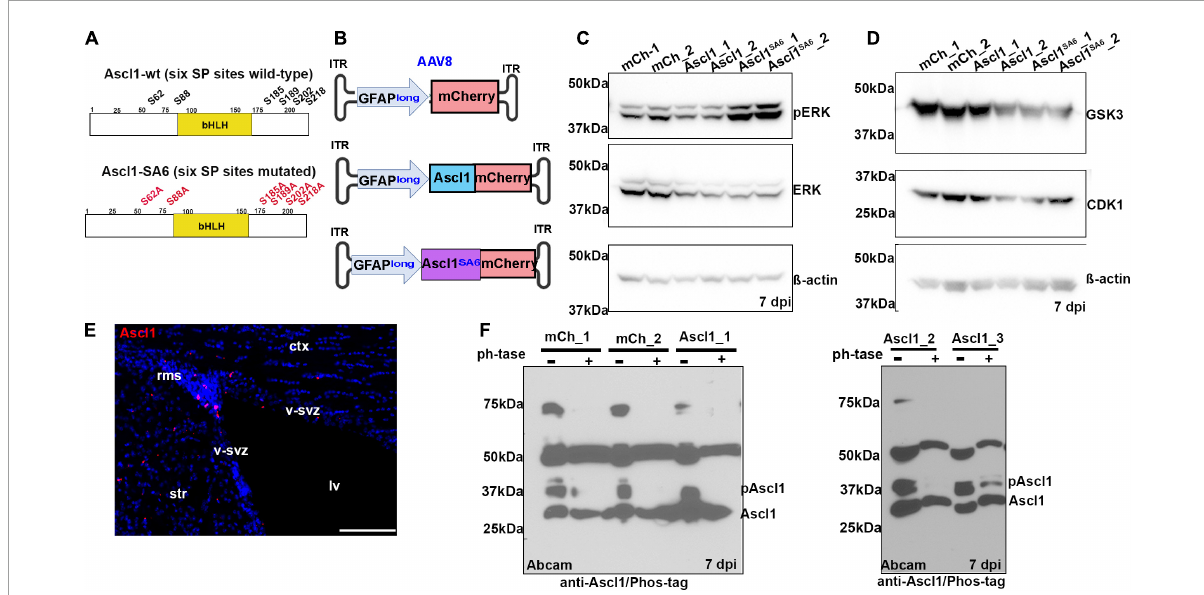
FIGURE1 Ascl1 is phosphorylated by proline-directed serine-threonine kinases in the adult brain in vivo. (A) Schematic illustration of the sequence of wild-type (wt) Ascl1 with SP sites designated, and Ascl1 SA 6 , with SA mutations indicated. (B) Schematic illustration of AAV8-GFAPlong-mCherry vectors. (C,D) Western blot analysis of lysates from right (sample 1) and left (sample 2) cortical hemispheres transduced with AAV8-GFAPlong-mCherry (mCh), AAV8-GFAPlong-Ascl1-mCherry (Ascl1) or AAV8-GFAPlong-Ascl1 SA 6 -mCherry (Ascl1 SA 6 ), analyzed for the expression of pERK, ERK, and β -actin (C) , or GSK3, CDK1, and β -actin (D) . (E) Ascl1 expression in the ventricular-subventricular zone (V-SVZ) in a coronal section of the adult cortex. (F) Phos-tag western blot of cortical lysates from left (sample 1); left (sample 2); and right (sample 3) cortical hemispheres transduced with mCherry or Ascl1-mCherry in two independent experiments shown in separate gels either treated or not with Lambda protein phosphatase (ph’tase) and blotted with anti-Ascl1 (Abcam). Scale bars in panel E = 100 µ m. ct, cortex; lv, lateral ventricle; rms, rostral migratory stream; str, striatum; v-svz, ventricular-subventricular zone. Significance was defined as p -values less than 0.05 and denoted as follows: ns, not significant, < 0.05 *, < 0.01 **, < 0.001 ***.